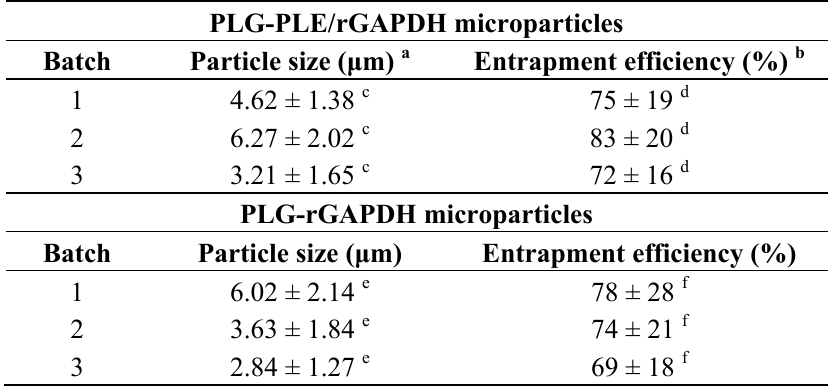
Table 1. Particle size and entrapment efficiency of PLG-encapsulated